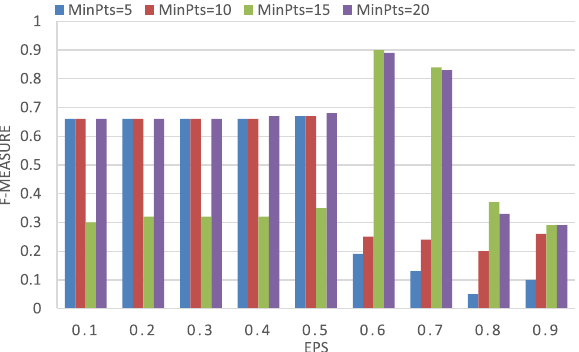
Fig. 5. E®ect of the variation of the parameter eps.